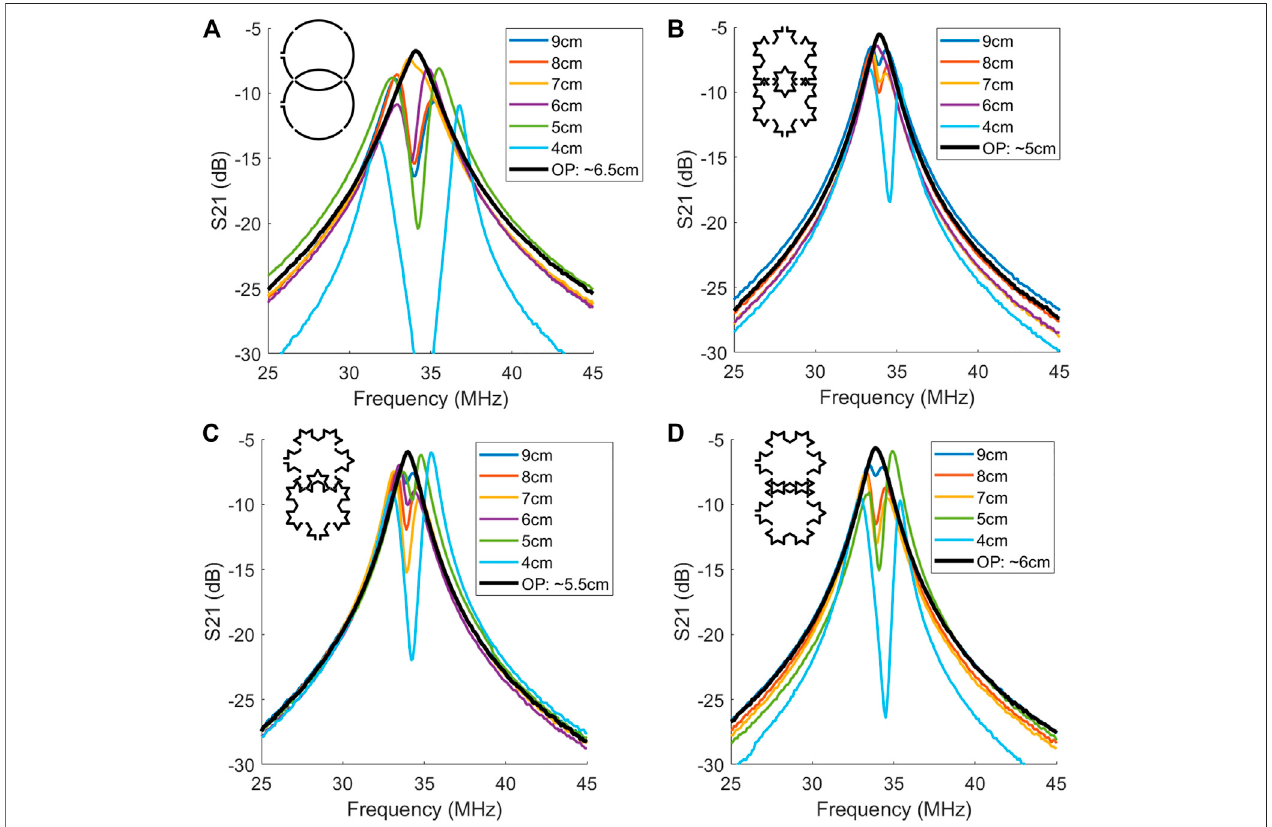
FIGURE4| The S 21 curves(indB)of (A) thecircularcoilpair, (B) longaxis(LA)overlapofthefractalpair, (C) mixedaxis(MA)overlapofthefractalpair,and (D) short axis (SA) overlap of the fractal pair. The coil diagrams in the top left corner of each plot show the coil con fi gurations. The black “ OP ” curve is the curve at an optimal distance of separation where the mutual inductance goes to zero and the curve merges into one singular peak.